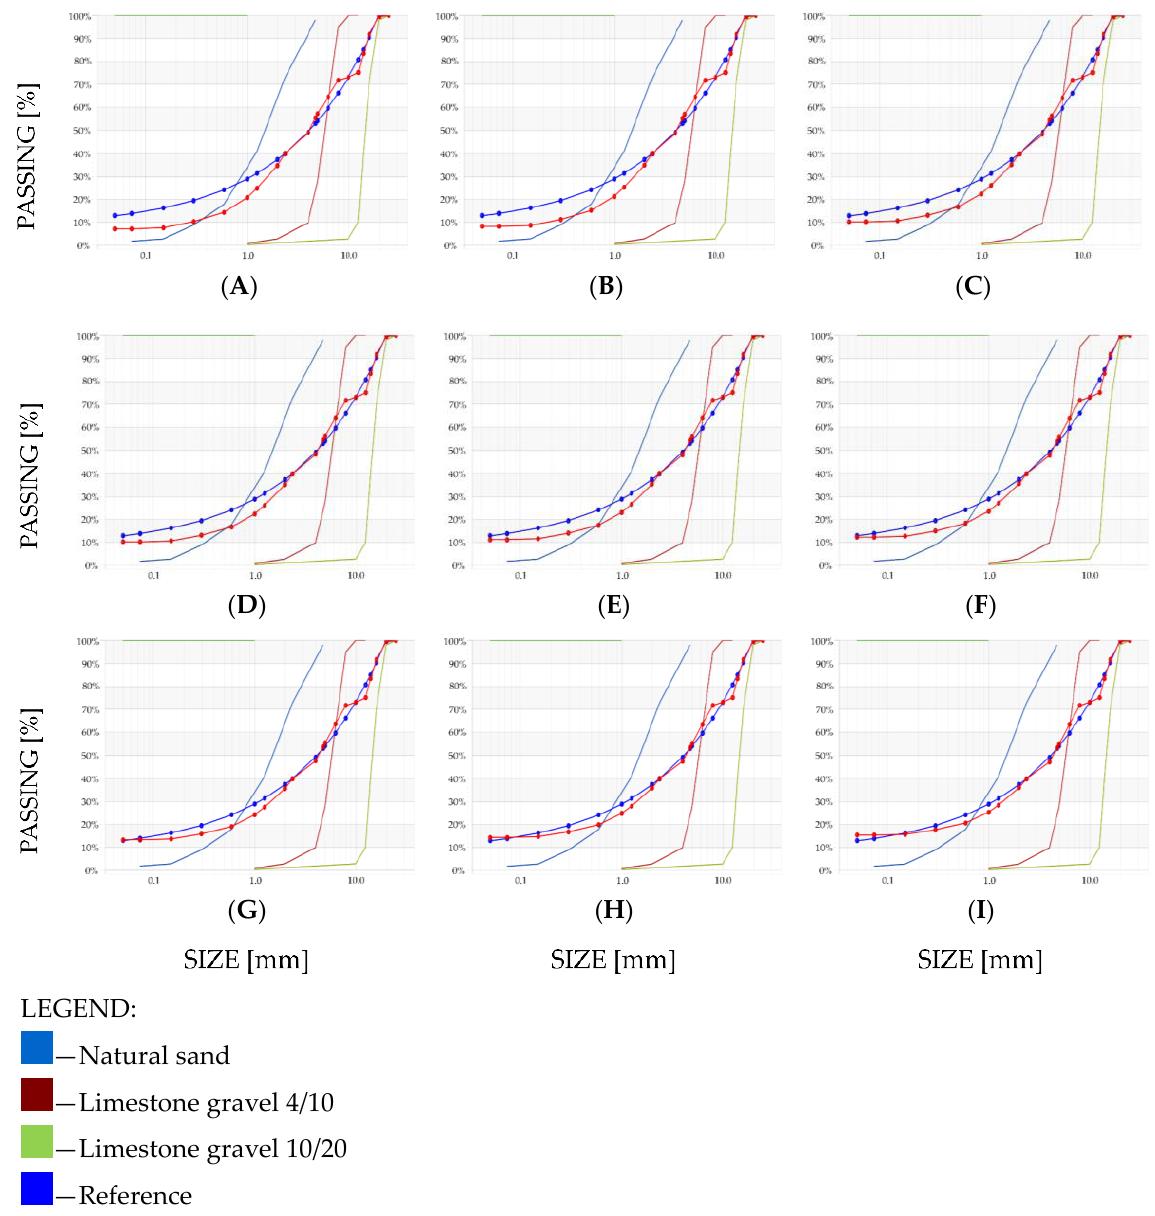
Figure A3. Gradings and fitting curves for Recipe #2—standard mix with plasticizer (lignosulfonate), superplasticizer (polycarboxylate ether) and air entrainer (tensides) designed according to the Bolomey Method: ( A ) 10 MPa; ( B ) 15 MPa;